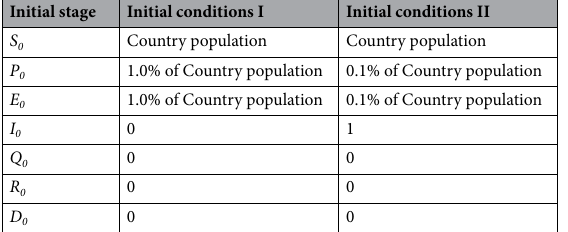
Model trend Initial conditions